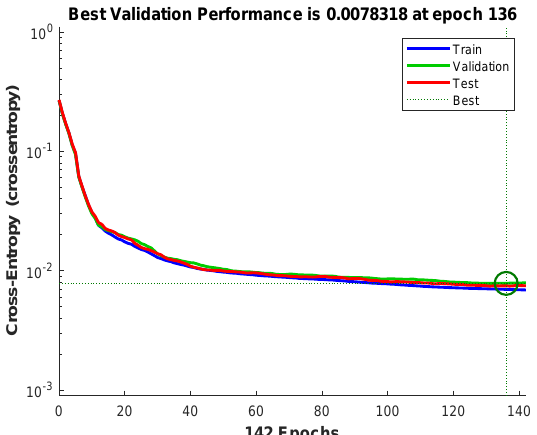
Figure 11. The mean-squared-error for the training and testing of the RB allocation